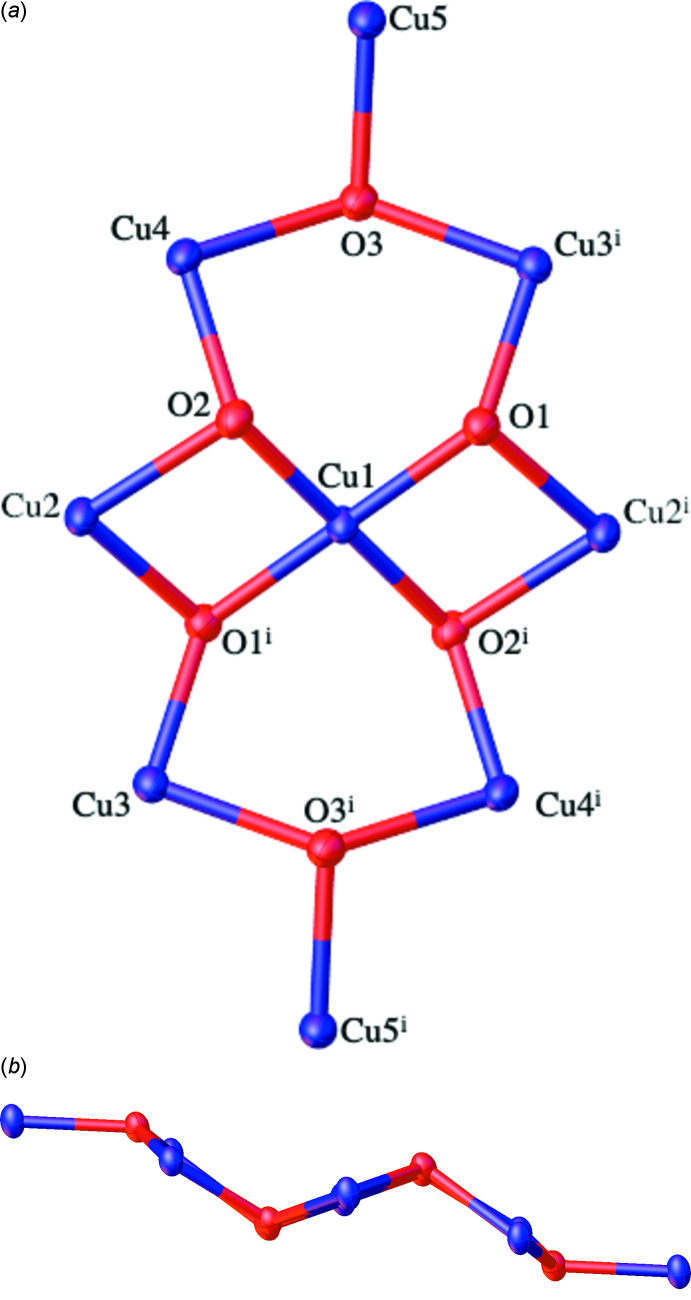
Central Cu9O6 core in (I) viewed (a) from above and (b) from the side.